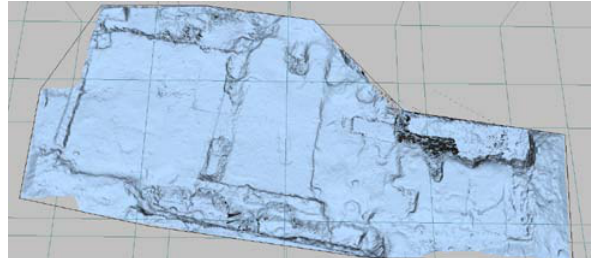
Figure 3. Screen shot of the employed images during the orientation process (previous page) and screen shot of the matching results (TIN visualization) of the analyzed portion (Image Master).